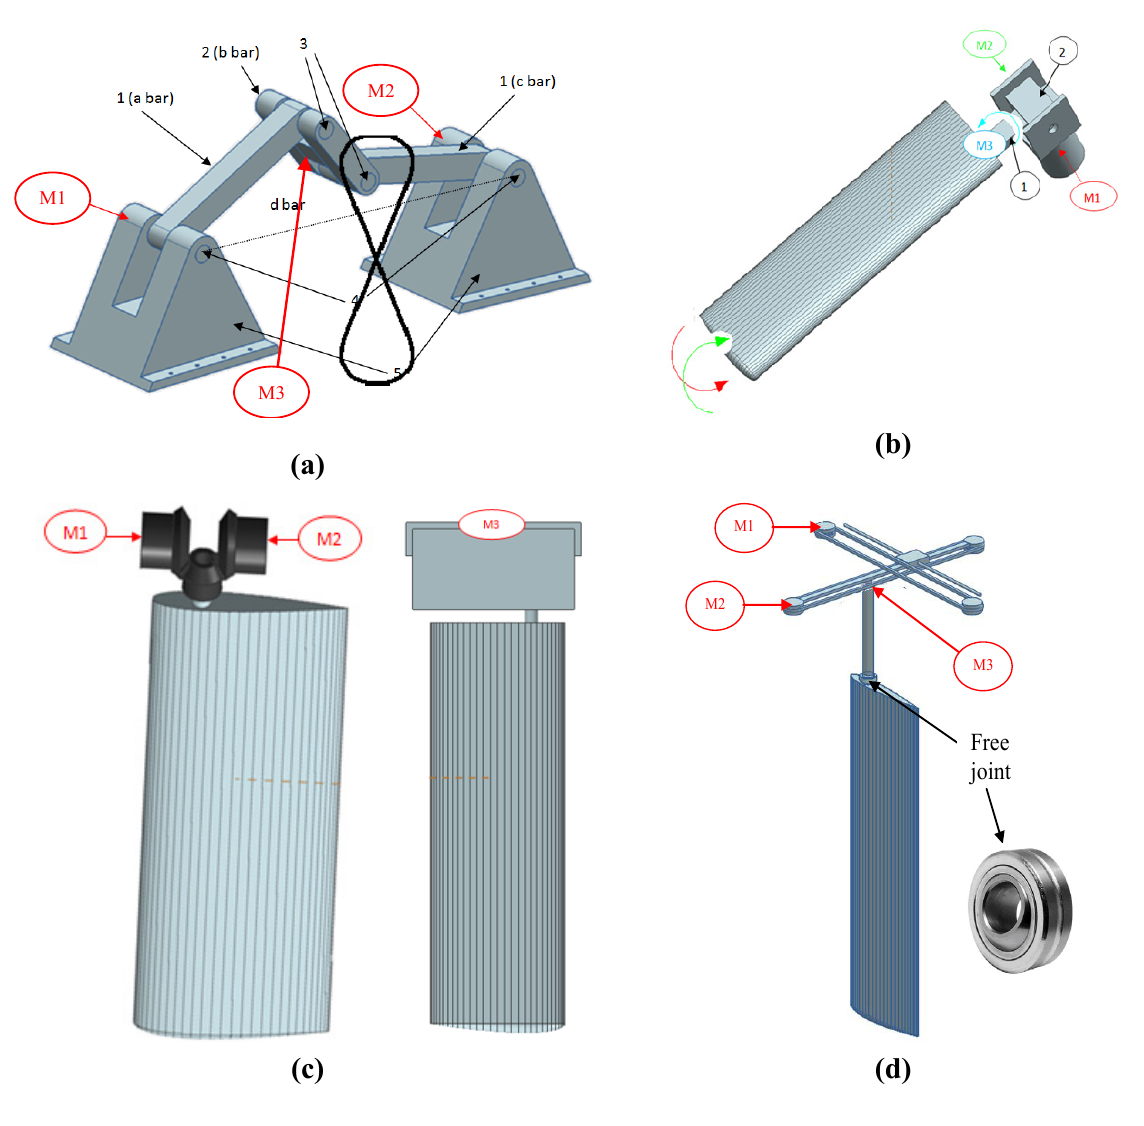
Figure 5. Alternatives considered for the hydrofoil propulsion mechanism: (a) 4-bar mechanism. (b) Ball-and-socket mechanism. (c) Differential mechanism. (d) Translational pulley